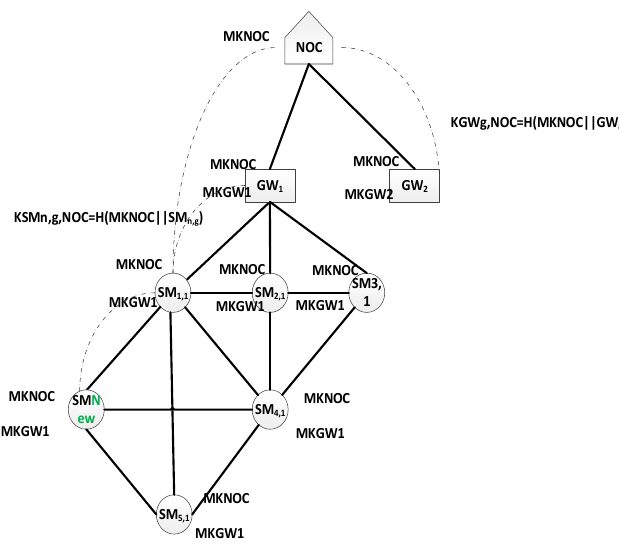
Figure 6. Authentication for a multi-hop NAN topology.